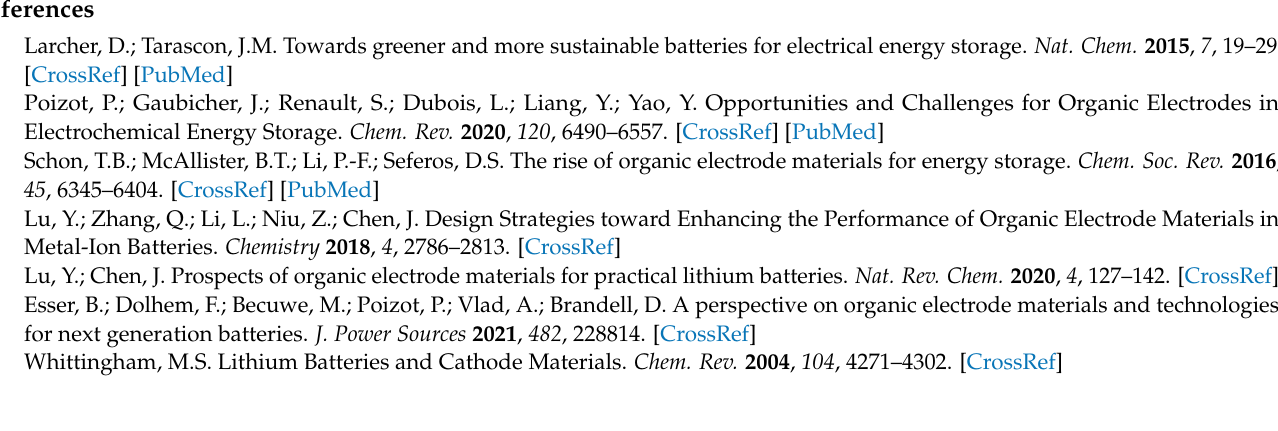
Table S1: Calculated electrochemical potential of quinone-based redox-active species; Table S2: BLA and averaged bond lengths in the lithiated Ni(II)(L1) 2 ; Table S3: Averaged NBO charges in the lithiated Ni(II)(L1) 2 ; Table S4: BLA and averaged bond lengths in the lithiated Ni(IV)(L1) 2 ; Table S5: Averaged NBO charges in the lithiated Ni(IV)(L1) 2 ; Table S6: BLA and averaged bond lengths in the lithiated [Ni(II)L2] n ; Table S7: BLA and averaged bond lengths in the lithiated [Ni(IV)L2] n ; Table S8: Averaged AIM charges in the lithiated [Ni(II)L2] n ; Table S9: Averaged AIM charges in the lithiated [Ni(IV)L2] n ; Table S10: BLA and averaged bond lengths in the lithiated [Ni(II)L3] n ; Table S11: BLA and averaged bond lengths in the lithiated [Ni(IV)L3] n ; Table S12: Averaged AIM Table S14: Comparison between experimental and calculated electrochemical potentials of quinone- based molecules. Refs. [49,76–78] are cited in the Supplementary